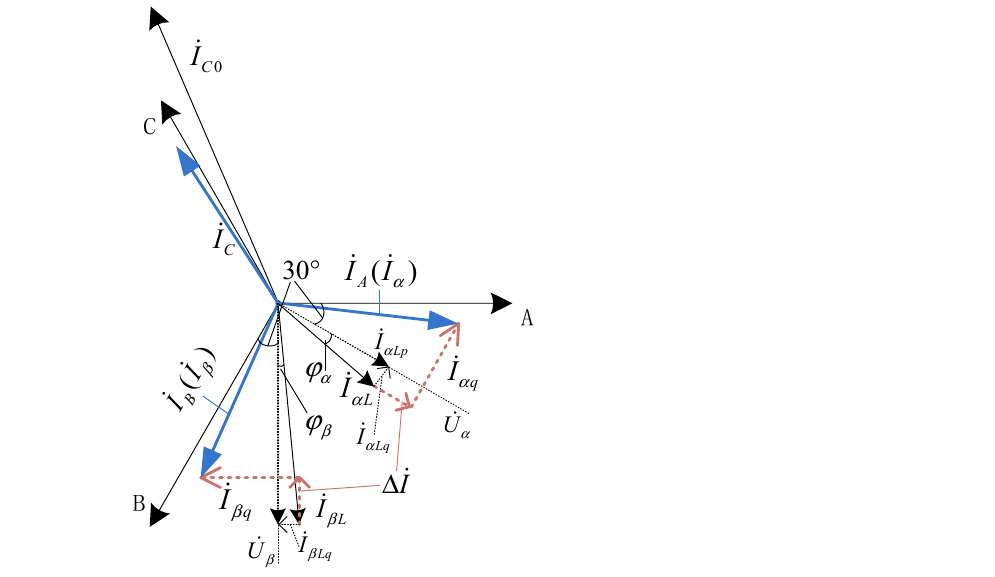
Figure 5. Phasor diagram of the system after compensation under actual conditions where φ α ≠ 0 and φ β ≠ 0. (This figure shows the case of φ α < 0, φ β > 0. The phasor diagram in other cases is similar to this figure. This article uses the situation in this figure to illustrate.)